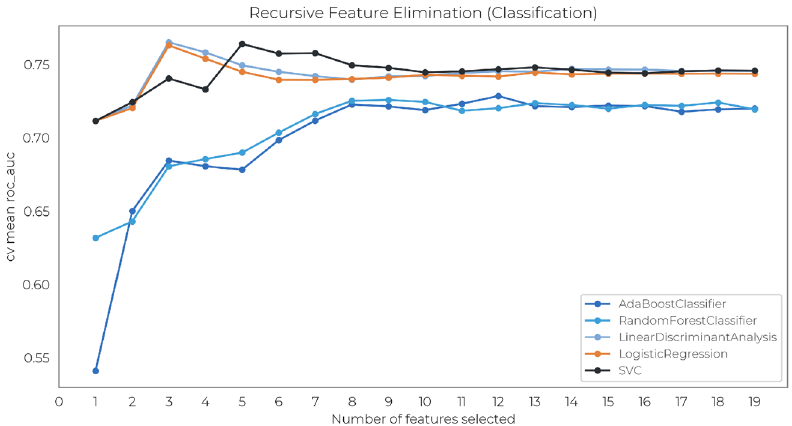
Figure 3. Example of feature selection using RFE schema with NHPT as a target. The x -axis shows the number of selected features, while the y -axis denotes the mean of AUC scores over k=5 folds for a given classifier. The final feature set is constructed by considering the most recurring features among all trained models where the mean AUC-ROC is maximized. One can also observe a performance plateau whenever more than eight features are used as predictors, regardless of the type of classifier.